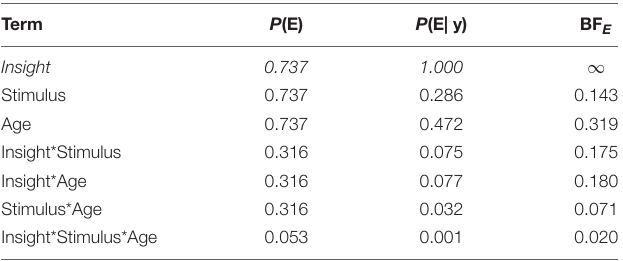
TABLE 8 | Results for all included terms in the Bayesian model comparison for proportion of reported Aha! experiences of incorrectly and correctly solved items. Term P (E) P (E| y)